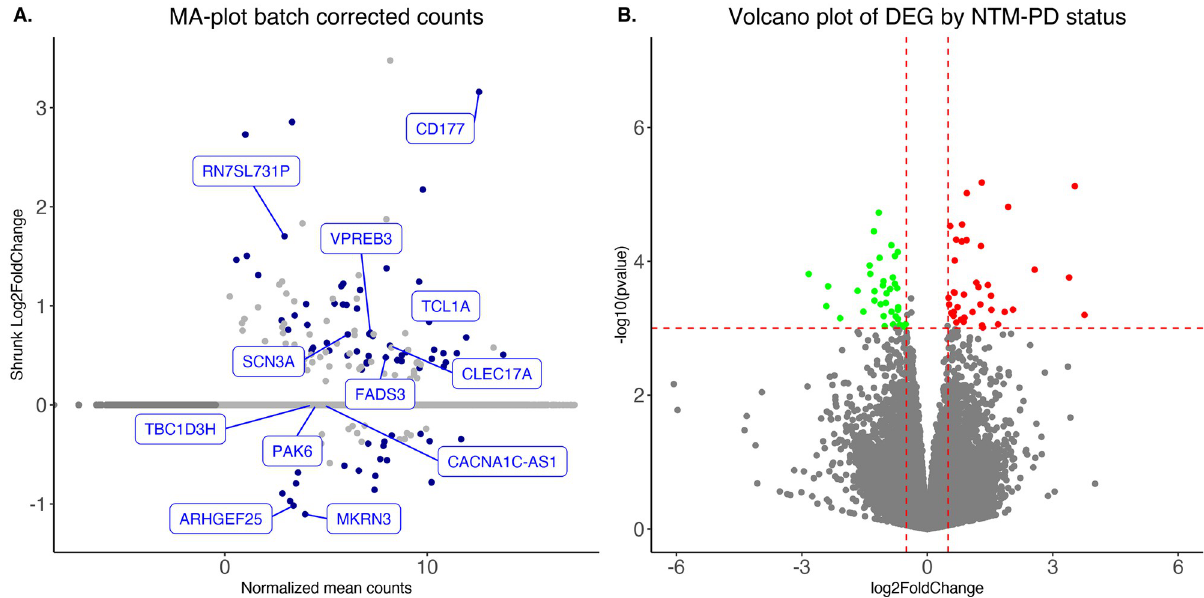
Fig 1. Volcano plot and MA plot of DESeq2 differential expression analysis. (A) Bland-Altman plot of normalized mean counts and shrunk (apeglm) Log2 fold-changes. The differentially expressed genes are in red, and the top 15 features are labeled. (B) Volcano plot of differential gene expression analysis with cut-offs of p < 0.001 and Log2 fold-change larger than absolute 0.5. Highlighted in red are genes with higher transcription levels in patients who progressed to NTM-PD, in green are those with lower expression in the same group.